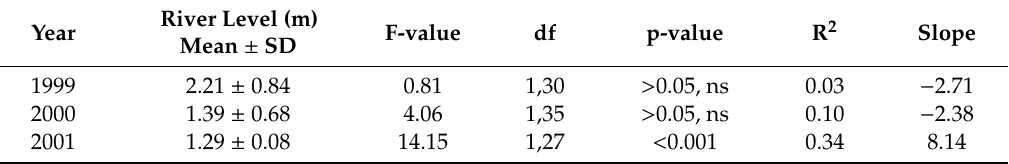
Figure 3. Daily river fluctuations (solid black line) and nest numbers (grey bars) during the dry and rainy season of the Tawadu-Nichare Rivers, Venezuela. Three nesting seasons are ( a ) 1999, ( b ) 2000, and ( c ) 2001. For year 2001 grey bars at the right side represent the hatching portion. The arrows points to when beach flooding occurred. Table 2. Results from regression analyses of number of nests oviposited vs. daily river level (m) during three consecutive years. Variables were Log n -transformed (except for year 1999).